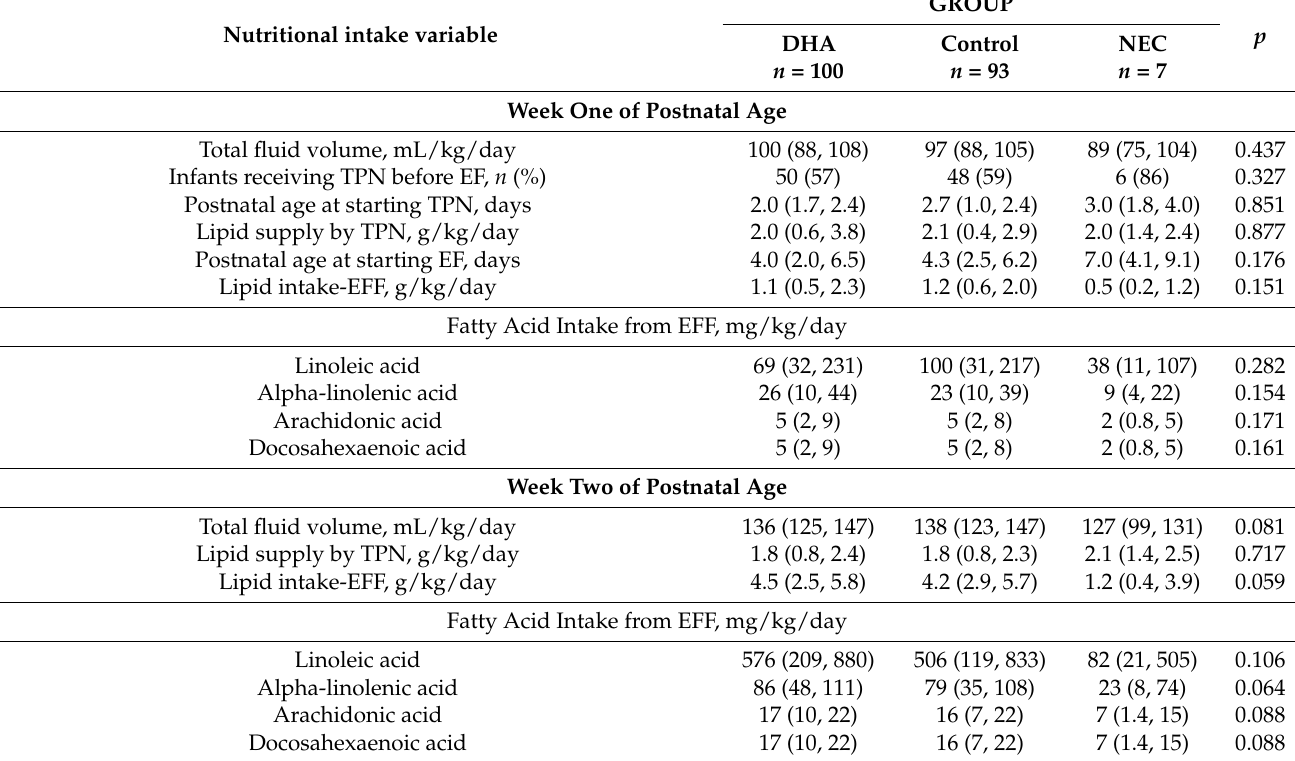
Table 4. Nutritional support of the preterm infants during the hospital